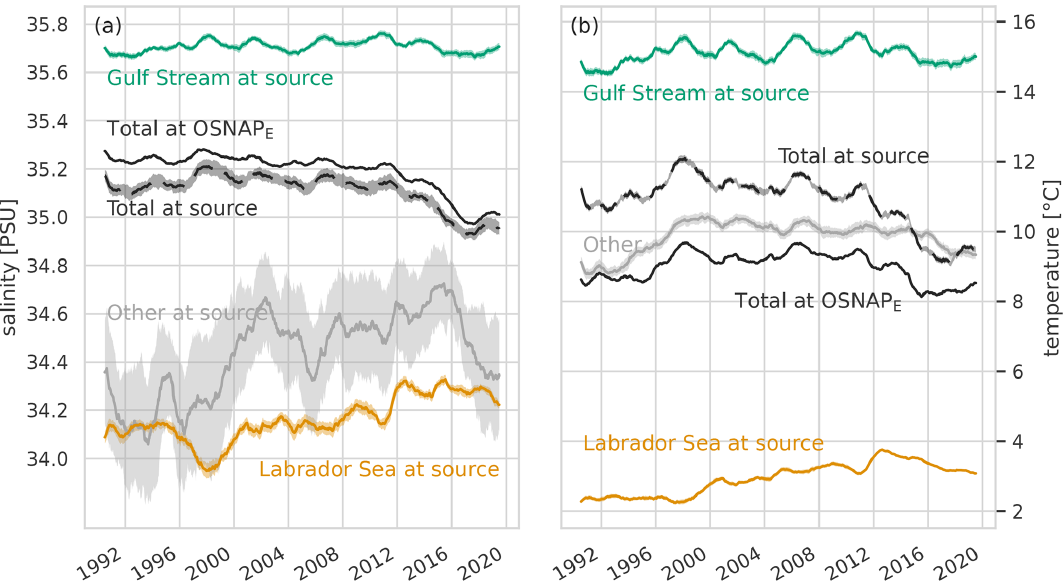
Figure 6. Salinity (a) and temperature (b) time series at the source and at OSNAP E . For salinity, (a) , time series of the 1-year running mean salinity at OSNAP E − 37W − 500m (solid black lines) and at source (dashed black lines) show the mean freshening at the source to be reflected in an overall freshening recorded at OSNAP E − 37W − 500m . This contrasts with temperatures (b) , where an overall at-source cooling (dashed black line) is mitigated by reduced along-track cooling (difference between the solid and dashed black lines), resulting in reduced cooling at OSNAP E − 37W − 500m (black solid line). Dividing the properties at source into the three origins (Gulf Stream (green), Labrador Sea (orange), and other (grey)), none shows consistent freshening or cooling. The x axis is the time that water parcels cross OSNAP E − 37W − 500m . Shaded areas show ± 1 . 96 standard deviations between the 32 subsets. Uncertainties are larger for the “other” source because the sample size is smaller and these particles originate in a wide range of conditions throughout the subpolar North Atlantic south of OSNAP E rather than in tightly defined source regions.